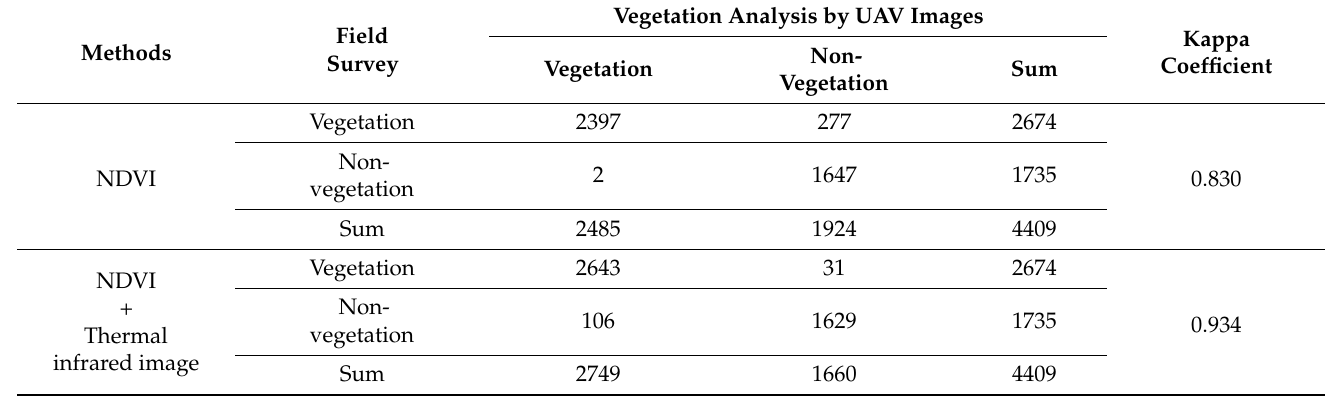
Table 9. Analysis of the kappa coefficient for vegetation